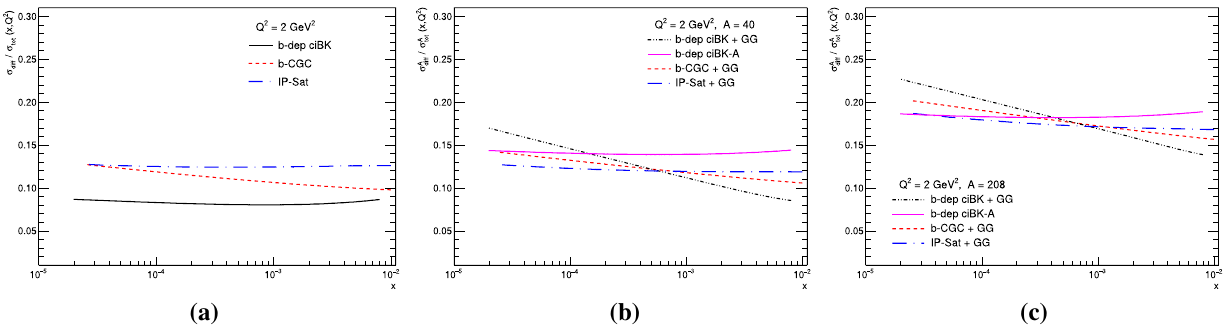
Fig. 5 Predictions for the x dependence of the ratio R σ = σ diff /σ tot for a A = 1, b A = 40 and c A = 208, considering distinct models for the dipole-target scattering amplitude and a fixed photon virtuality ( Q 2 = 2 GeV 2 )